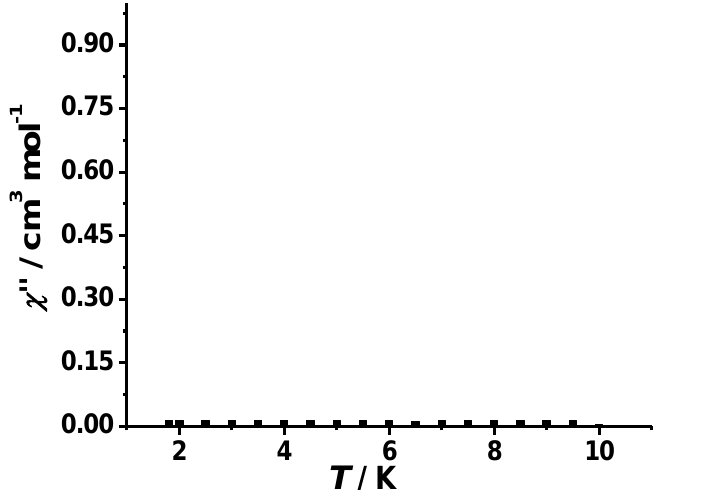
Figure 6. Variable-temperature AC magnetic susceptibilities (out-of-phase) of complex 1 in an AC field of 5 Oe with a constant frequency of 997 Hz.